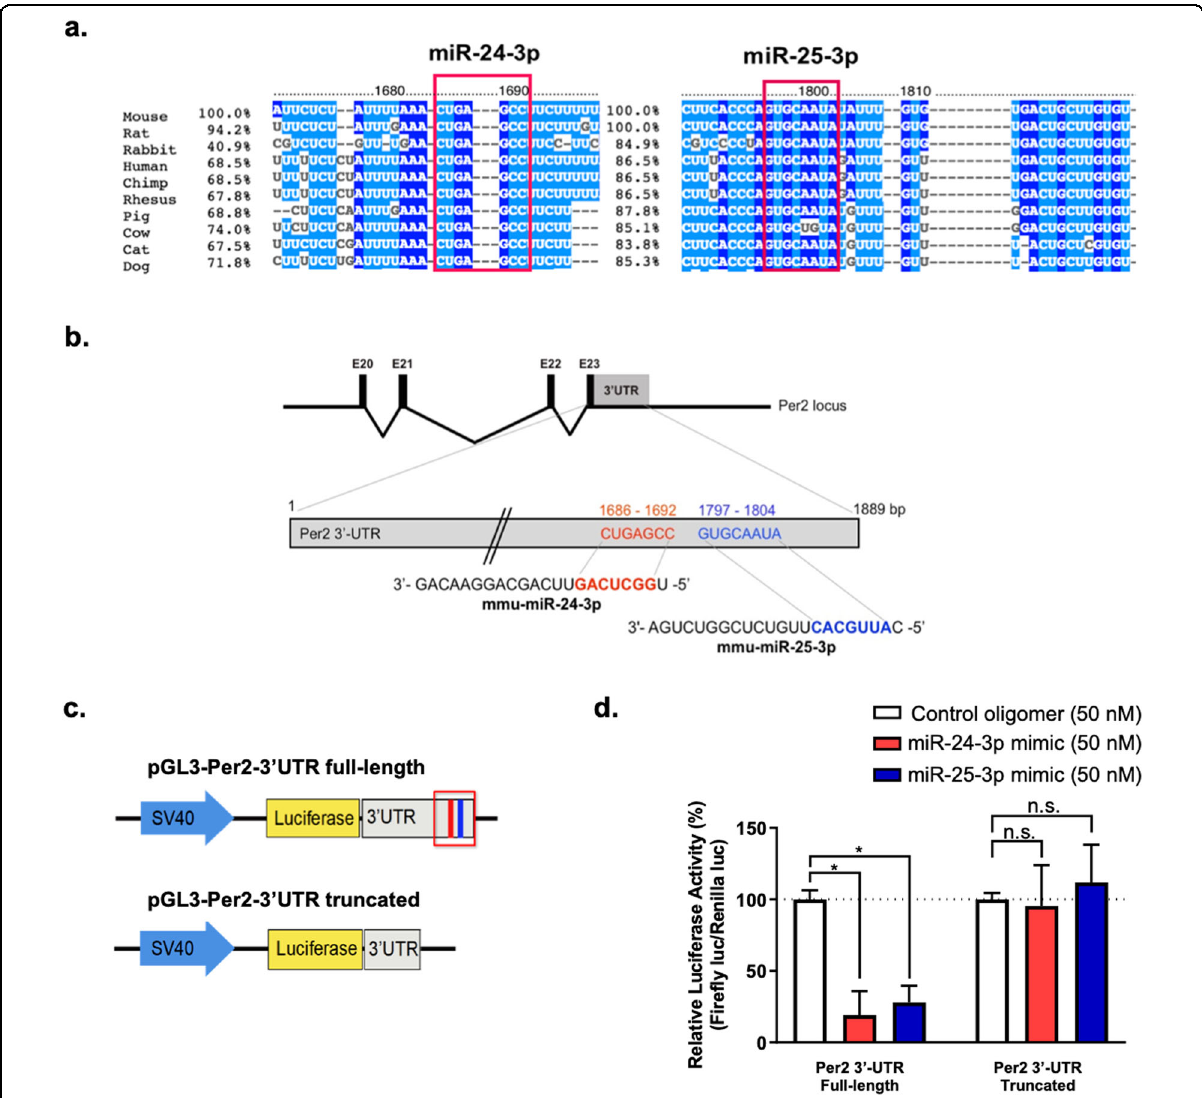
Fig. 1 Candidate microRNAs targeting the 3 ′ -untranslated (UTR) region of Period2 (Per2) . a Conserved miR-24-3p and miR-25-3p binding sites on the 3 ′ -UTR of Per2 in several vertebrates (indicated with red outlines). b Predicted binding sites of miR-24-3p (red) and miR-25-3p (blue) are illustrated on the 3 ′ -UTR of Per2 , and the 3 ′ -UTR targeting sequences of miR-24-3p and miR-25-3p are indicated. c Schematic of the constructed pGL3 vectors with binding sites on the 3 ′ -UTR of Per2 for the full-length or truncated miR-24-3p and miR-25-3p. Predicted binding sites of miR-24-3p (red bar) and miR-25-3p (blue bar) are illustrated on the 3 ′ -UTR of Per2 . d NIH3T3 fi broblasts were cotransfected with pRL-TK and either a